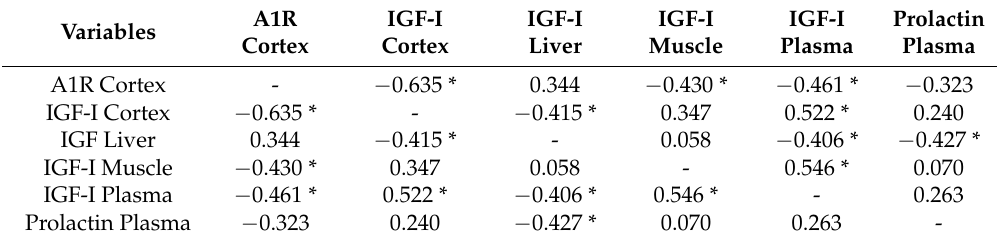
Table 3. Spearman correlation values (rank coefficient ( r ) and p ) between brain and peripheral biological